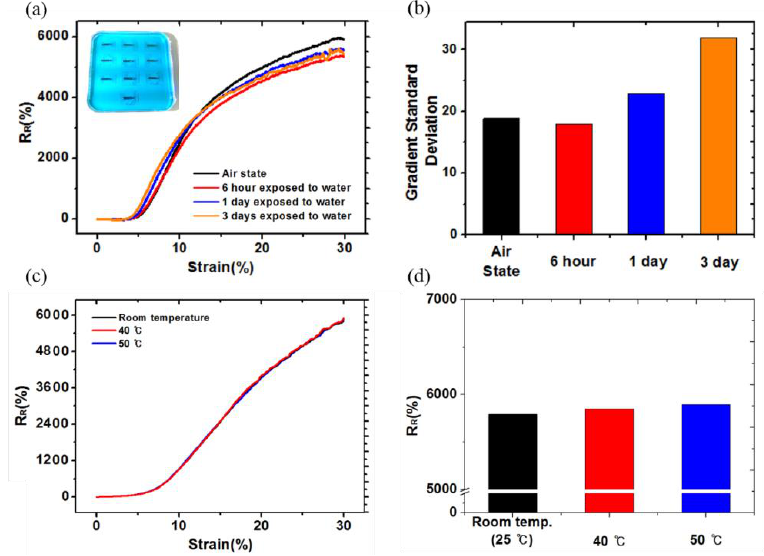
Figure 5. ( a ) Average relative resistance (R R )-strain curve of the sensors when they are exposed to water for long time; ( b ) gradient standard deviation of the sensor when it is exposed to water for long term; ( c ) the R R -strain curve of the sensor exposed to various temperatures (25 ◦ C, 40 ◦ C, 50 ◦ C); and ( d ) R R measured at 30% strain exposed to various